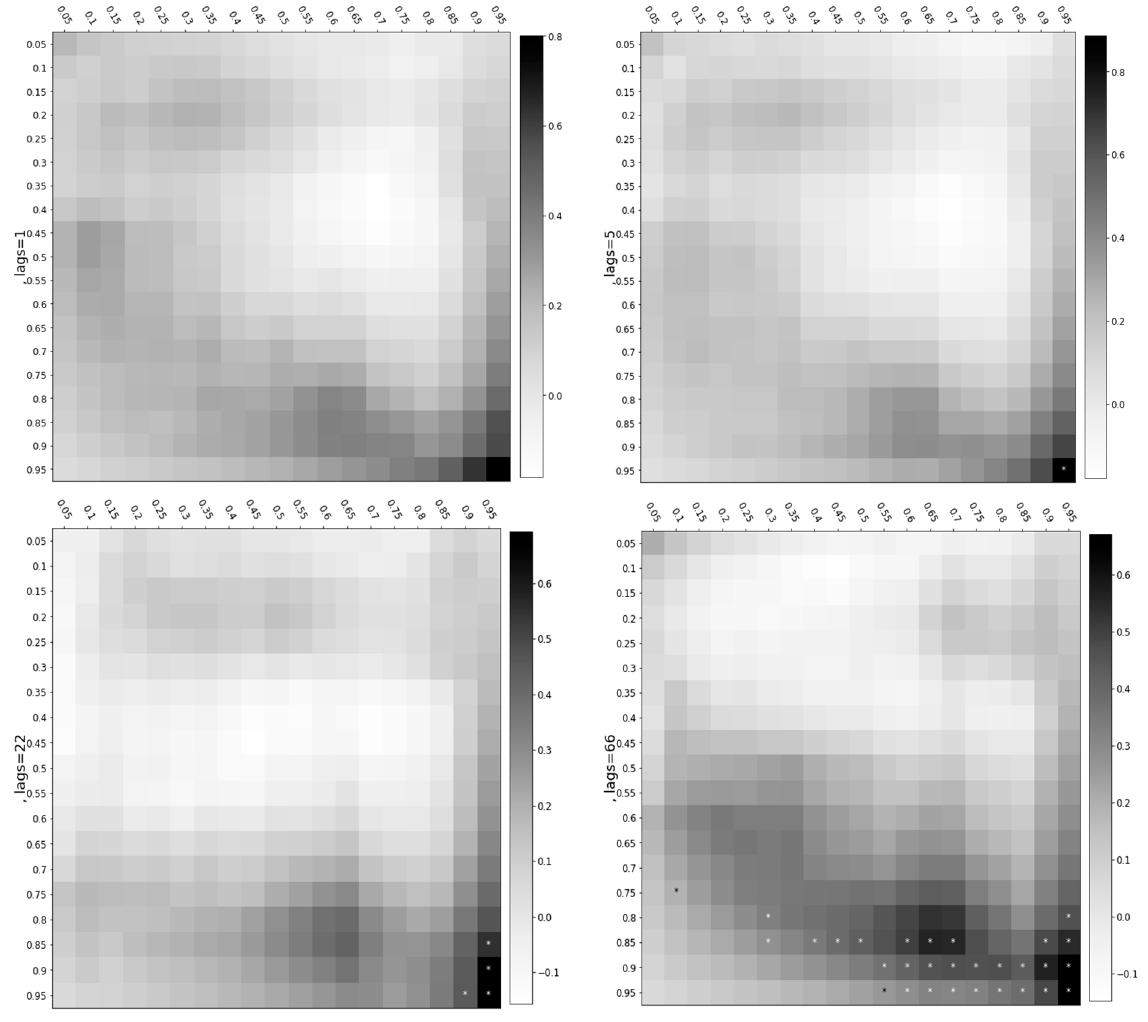
Figure 7. Cross-quantile dependence from Johnson & Johnson to Pfizer. Notes: The vertical axis indicates the quantile distribution of Johnson & Johnson’s stock return, whereas the horizontal axis indicates the quantile distribution of Pfizer’s stock return. The white-to-black intensity in the bar indicates negative to positive associations.